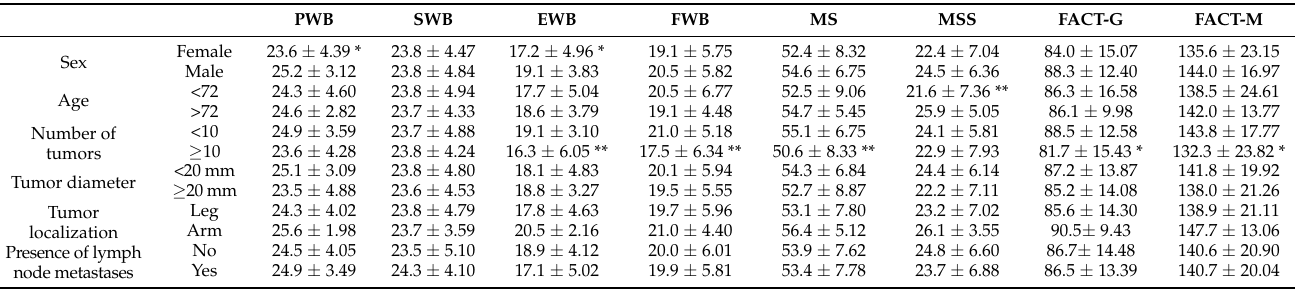
Table 3. Mean and standard deviation. FACT-General (FACT-G), Physical well-being (PWB), Social well-being (SWB), Emotional well-being (EWB), Functional well-being (FWB), Melanoma scale (MS), and Melanoma surgical scale